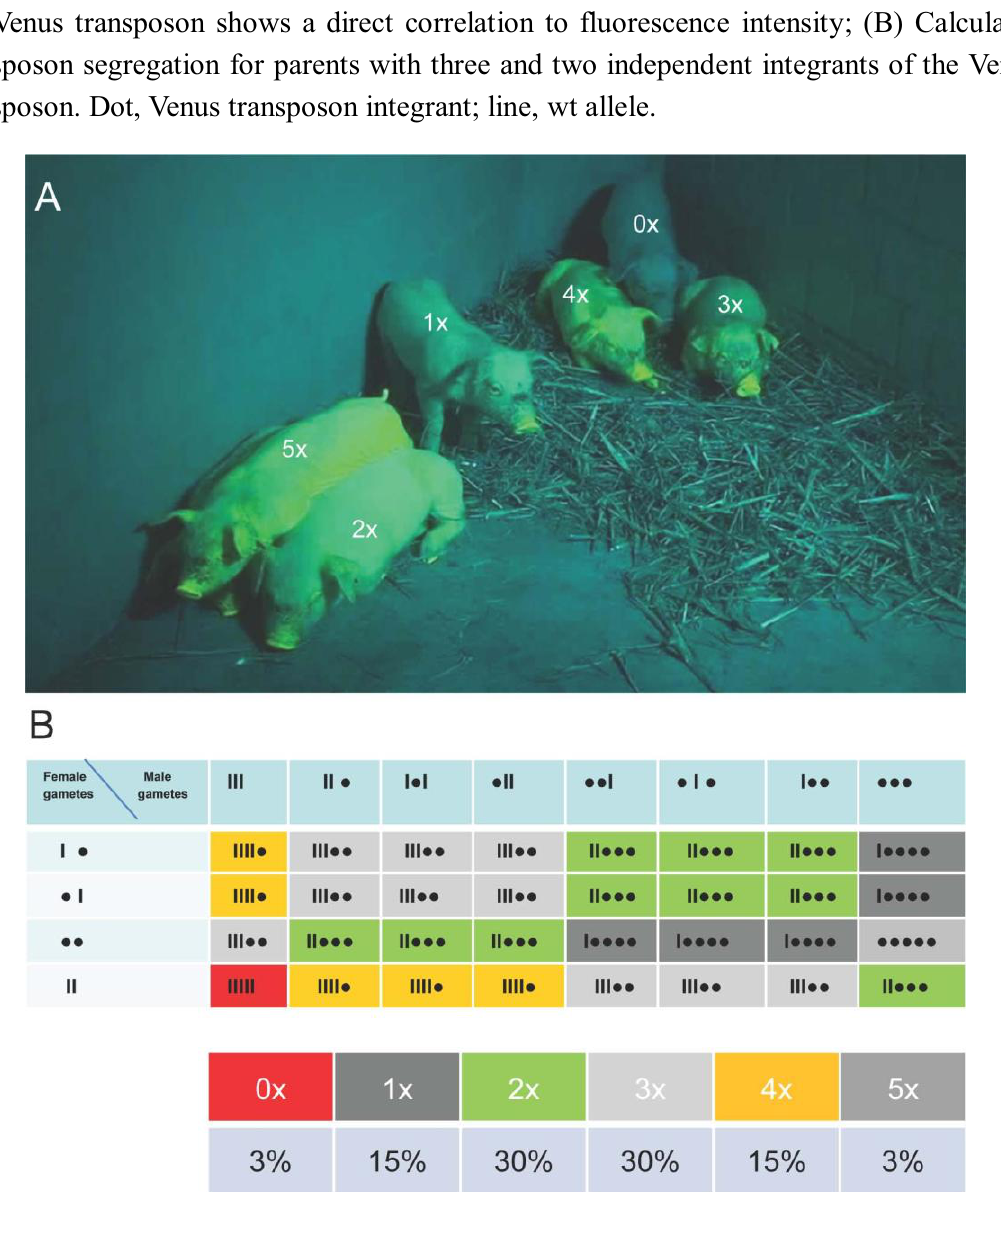
Figure 7. Maximized Venus expression by crossbreeding. (A) Female F1 sow # 518 (descendant of boar # 503) was inseminated with semen of the F0 boar #505. Seven of